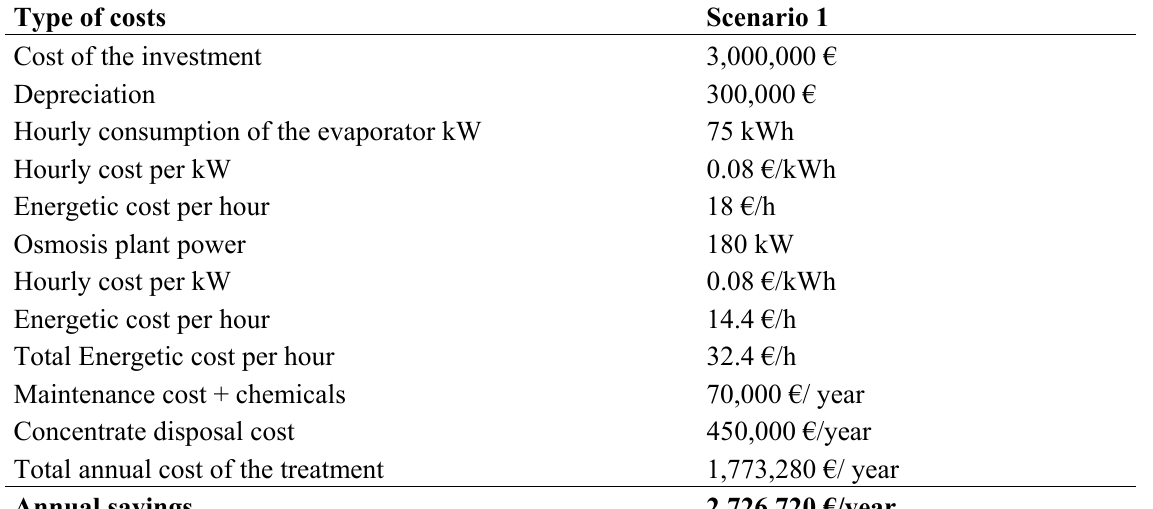
Table 3. Costs analysis Scenario 2.